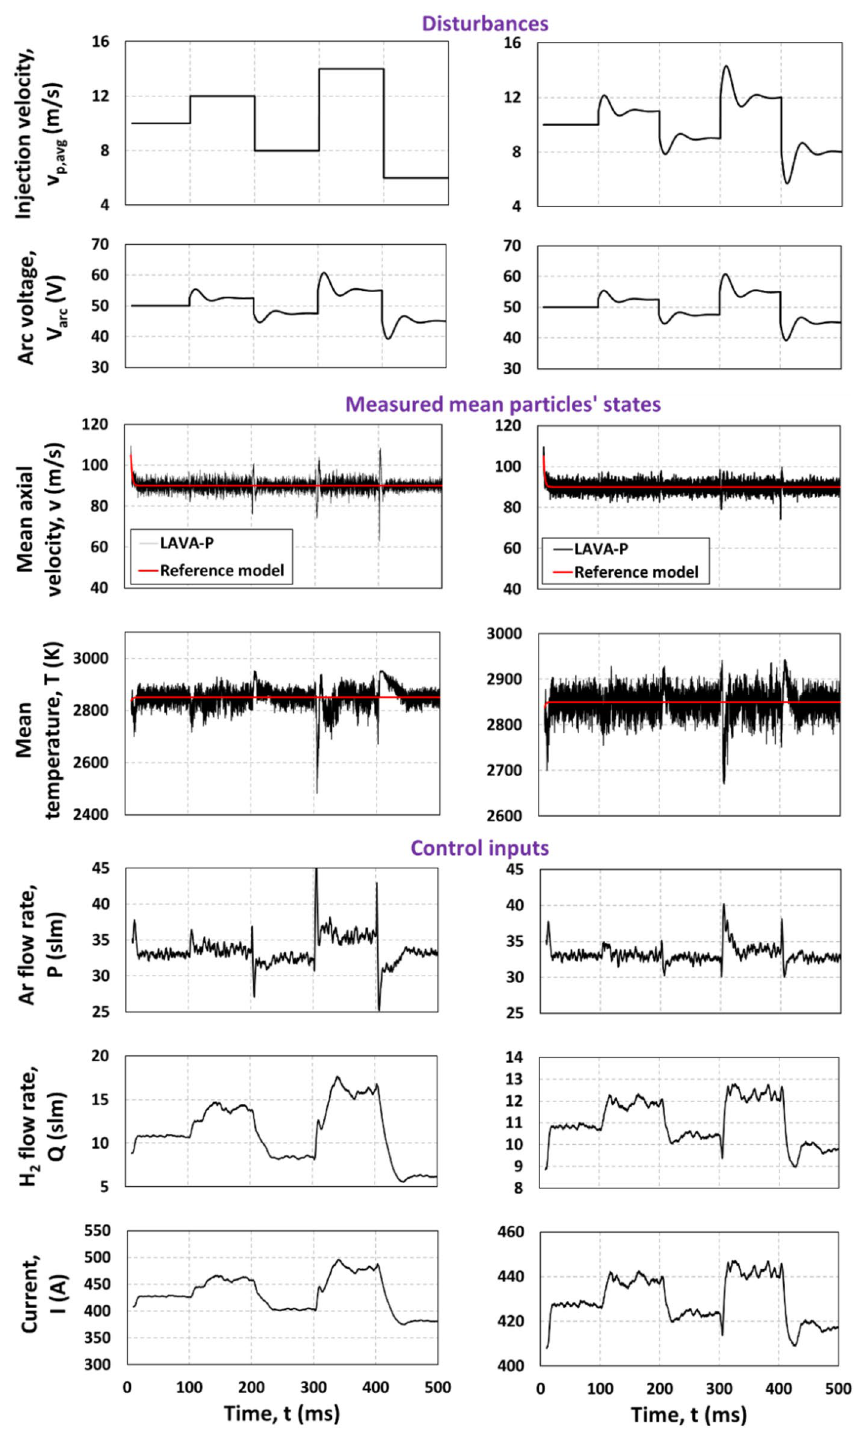
Fig. 7 The closed-loop responses of the MR-MRAC system in the presence of combined disturbances in the average powder injection velocity and the arc